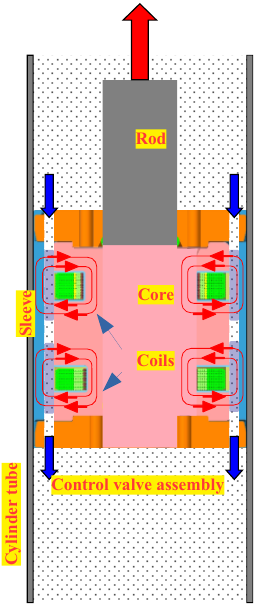
Figure 1. Example: MR actuator